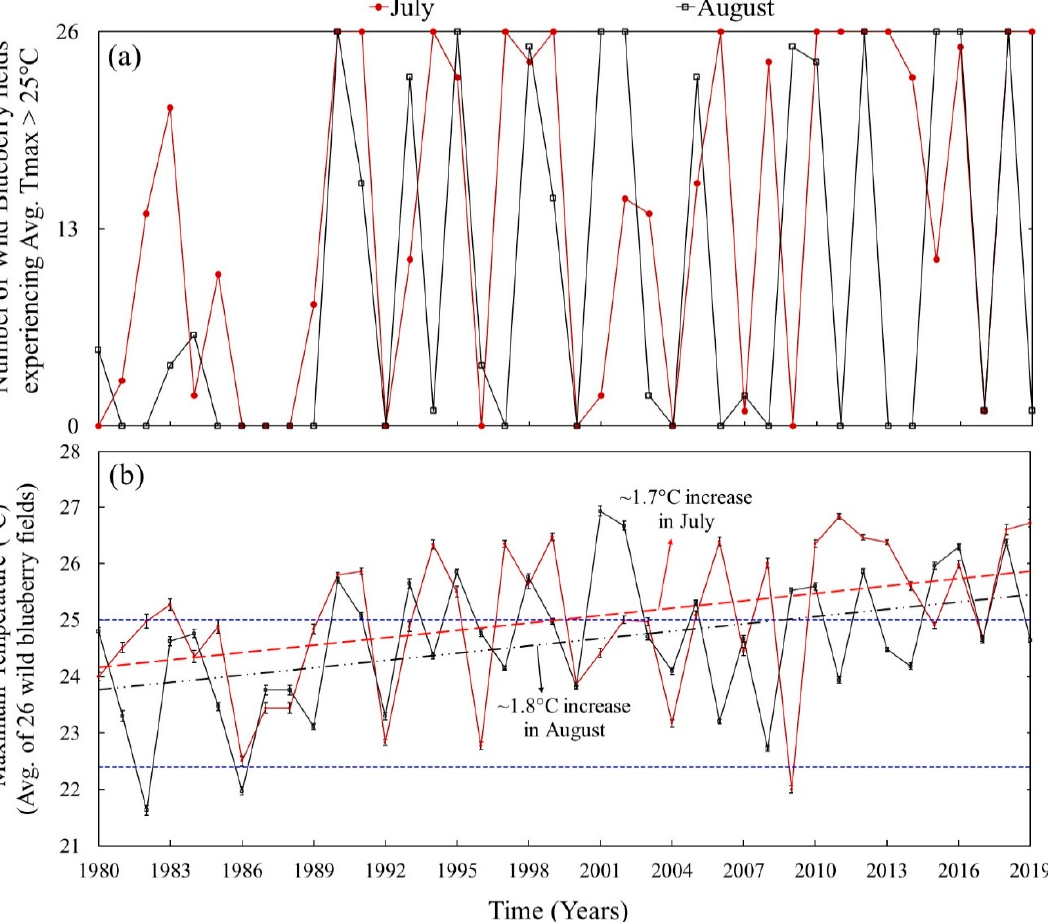
Figure 6. Maximum temperatures in the fields compared to optimum (threshold) maximum temperatures for enhanced vegetation index. ( a ) Number of wild blueberry fields among the 26 fields (shown in Figure 1) experiencing average maximum temperatures greater than 25 °C during July and August over the last 40 years (1980–2019). ( b ) Historical (1980 to 2019) changes in maximum temperature during July and August of the 26 wild blueberry fields (shown in Figure 1) in Downeast, Maine. The maximum temperatures from the fields are presented as means ± standard error (n = 26). The red solid lines with circles and the black solid lines with squares represent July and August, respectively. The dashed red lines and black lines are linear regression lines fitted to the data observed in July and August, respectively. The blue dotted lines represent the threshold maximum temperatures of 22.4 °C (observed from Figure 5a) and 25 °C (reported in the study by Tasnim et al. [9]).